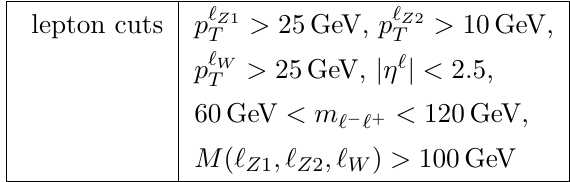
Figure 6 . Comparison of NNLO and N 3 LL+NNLO predictions for truth p W ± Z the CMS cuts in table 5.